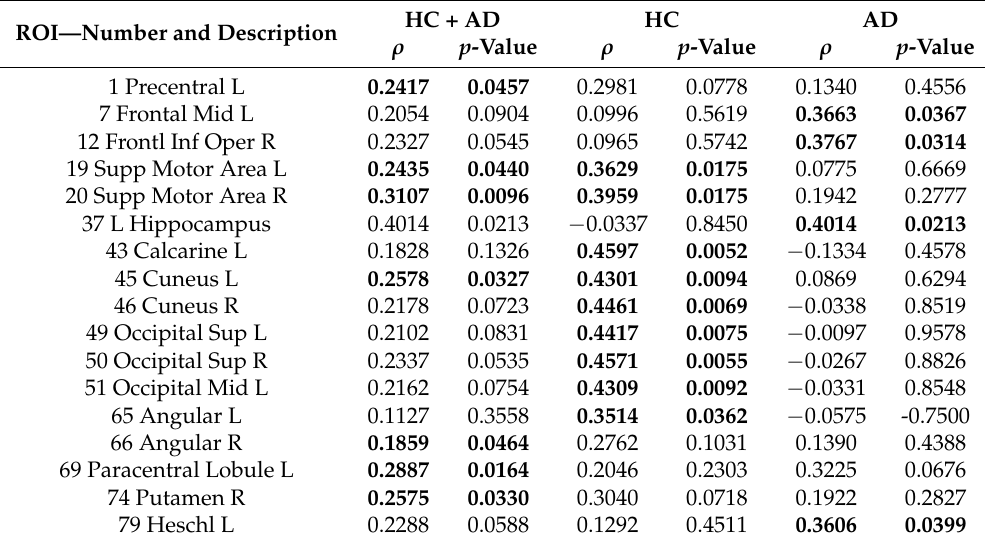
Figure 6. Correlation between the Clustering Coefficient (CC) and GMV ( a ) within groups in the right supplementary motor area ( ρ = 0.3107, σ = ± 1.998), ( b ) in the HC group in left calcarine ( ρ = 0.4597, σ = ± 0.4787), and ( c ) in the AD group in left hippocampus ( ρ = 0.4014, σ = ± 0.7299). The three regions with the highest correlation values are presented. Table 4. Regions with significant correlation between Grey Matter Volume (GMV) and the Clustering Coefficient (CC) across and with AD and HC groups. The area that survived Bonferroni’s correction is highlighted in bold